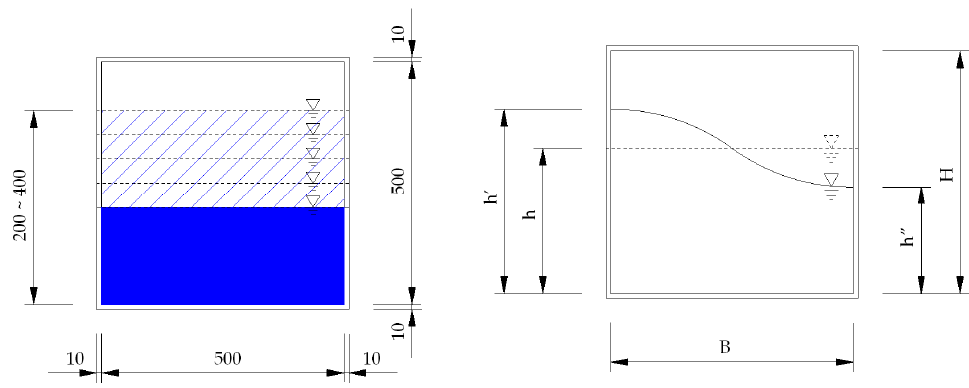
Figure 9. Analytical model for evaluating the influence of fluid height and structure width.